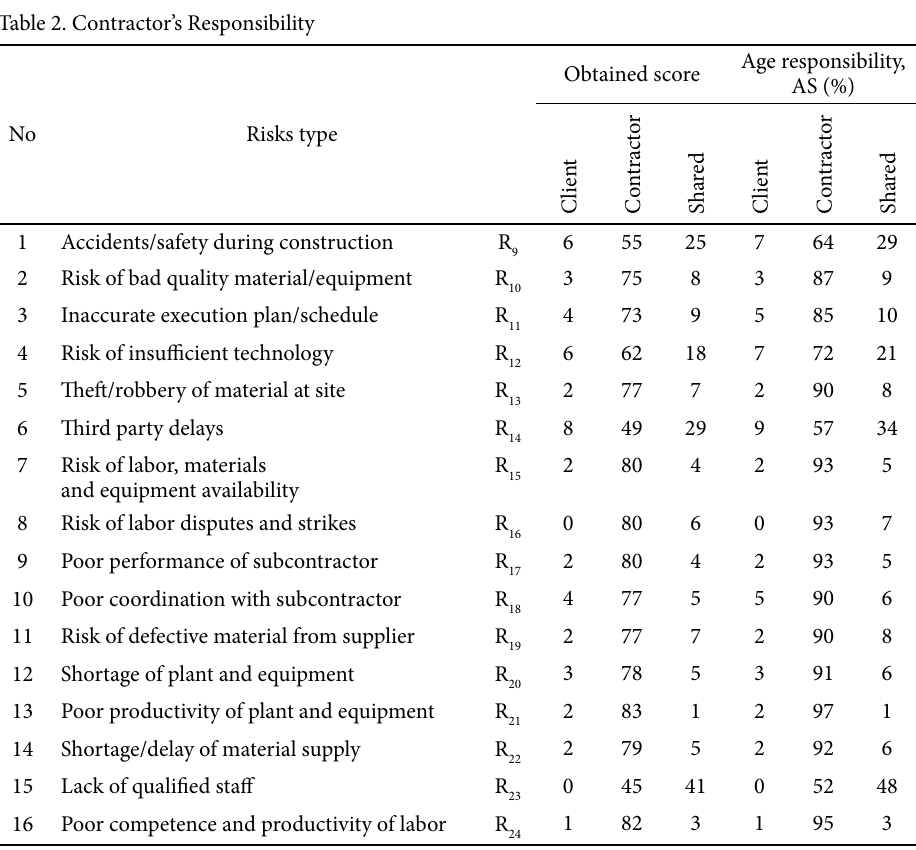
Table 2. Contractor’s